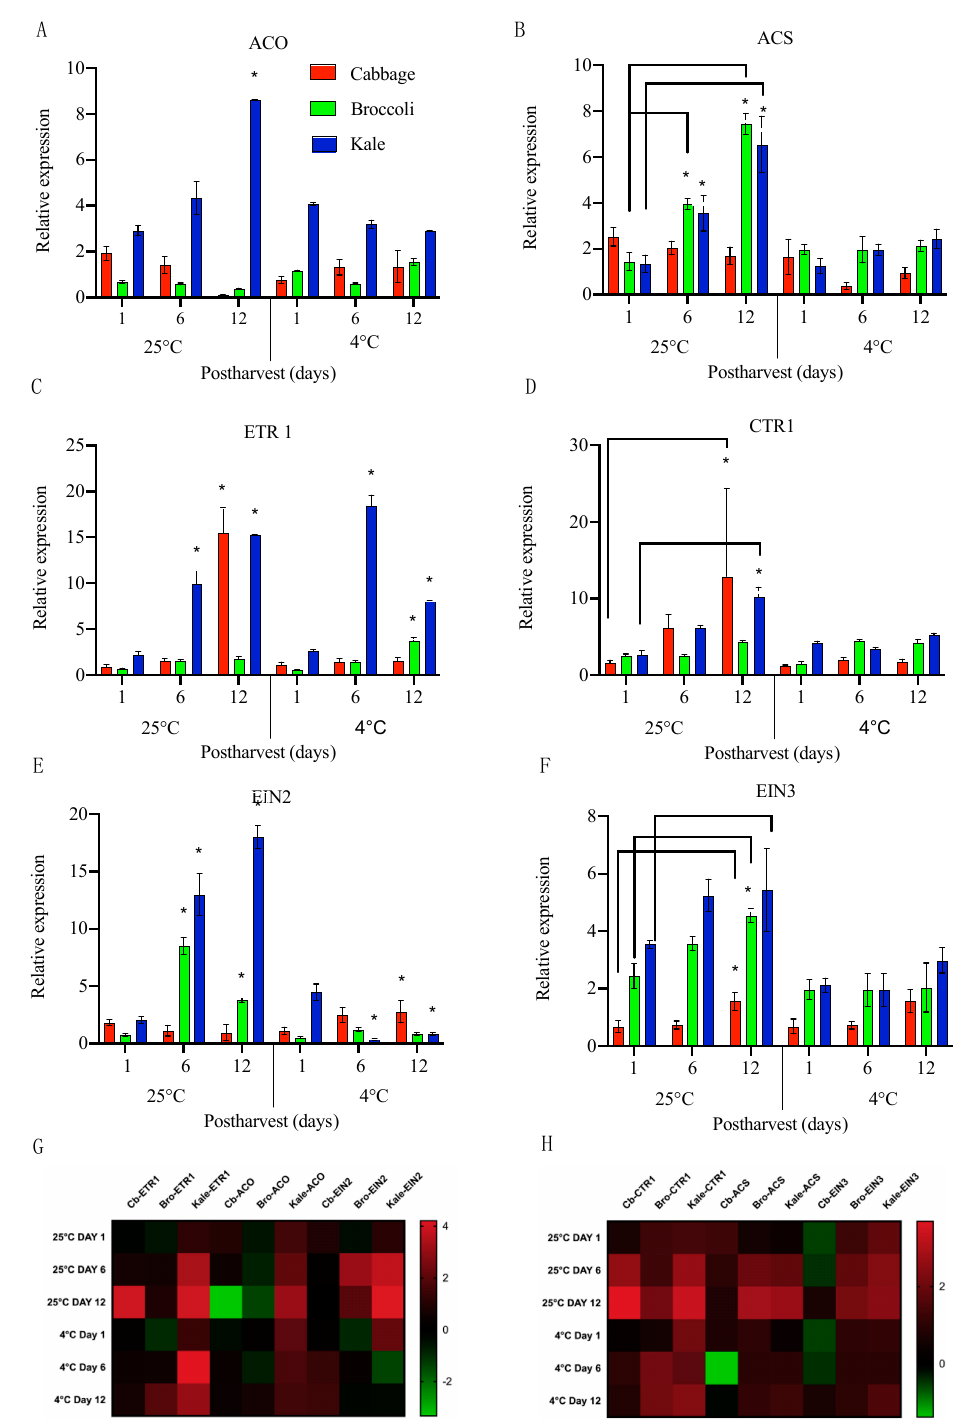
Figure 4. Relative transcript levels of ethylene biosynthesis (( A )- ACO and ( B )- ACS ), perception (( C )- ETR1 and ( D )- CTR1 ), and signaling (( E )- EIN2 and ( F )- EIN3 ) genes in cabbage, broccoli and kale stored at 25 ◦ C and 4 ◦ C on day 1, day 6 and day 12. Data represents means ± SE bars (n = 3 for each time points). Asterisks (*) if any indicate statistically significant differences between day 1 (control) and either day 6 or day 12 under the same storage condition ( p < 0.05). ( G , H ). Effect of storage temperature (25 ◦ C and 4 ◦ C) on selected ethylene-related genes represented as heap maps. Fold change is expressed as log2 ratio of transcript levels represented in the form of colors. Red color indicates upregulation and green color indicates downregulation. The heat map was constructed using graph-pad prism 8.4 software with the normalized expression